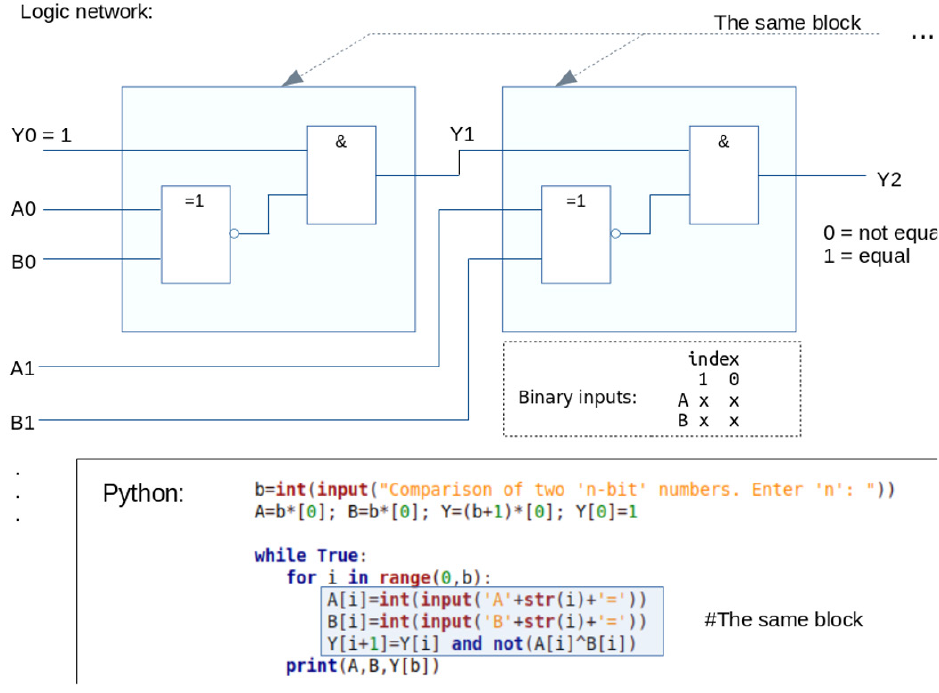
Figure 2. N-bit digital identity comparator as logic network and DCBLP code in